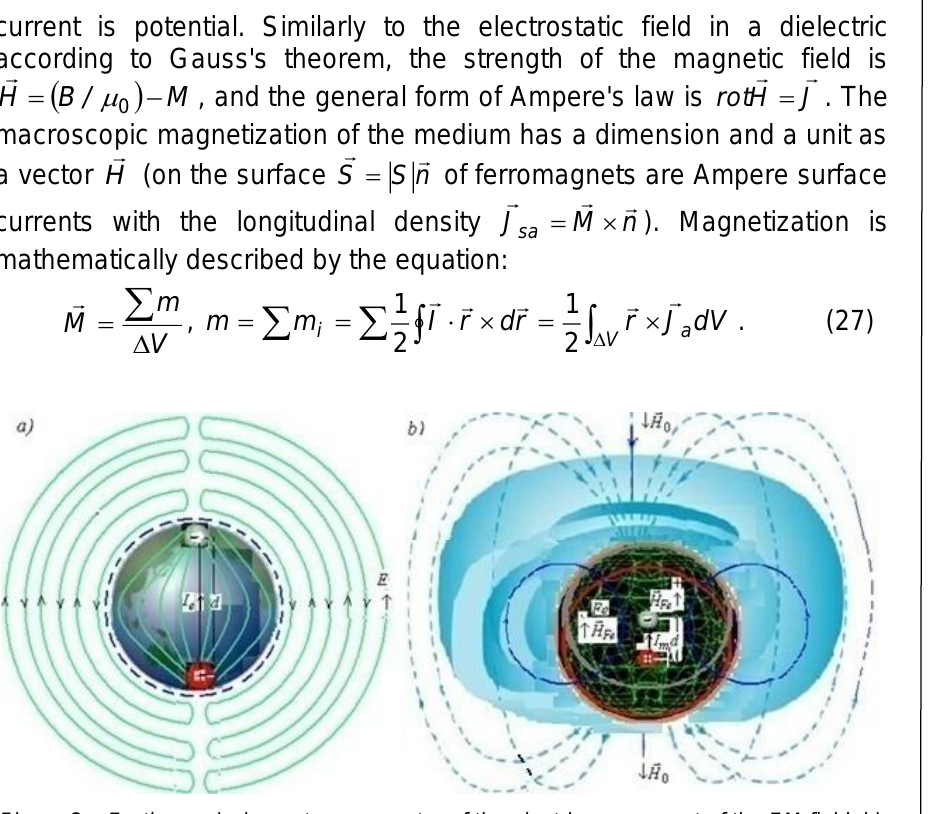
Figure 3 – Earth as: a) elementary resonator of the electric component of the EM field, b) Earth as a system that acts as an elementary dipole of the magnetic field (Bjelić,